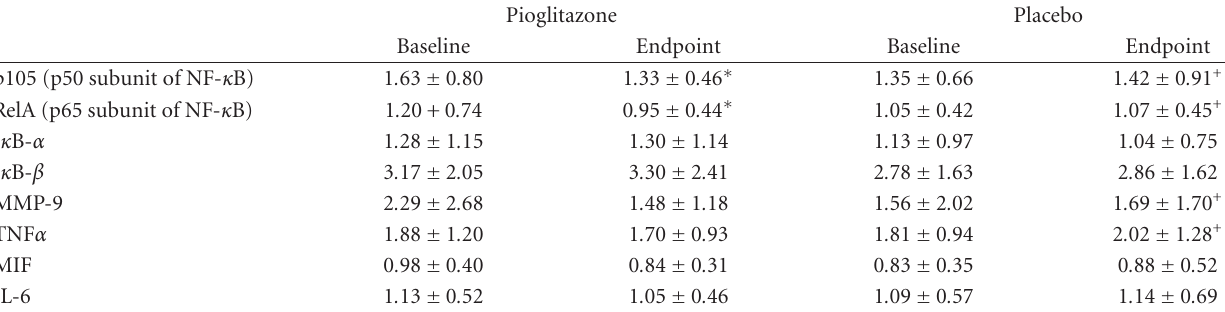
Table 3: mRNA expression of NF κ B and NF κ B-modulated cytokines in circulating peripheral mononuclear cells at baseline and after 4 weeks of therapy with pioglitazone or placebo (reference gene: ß-actin).